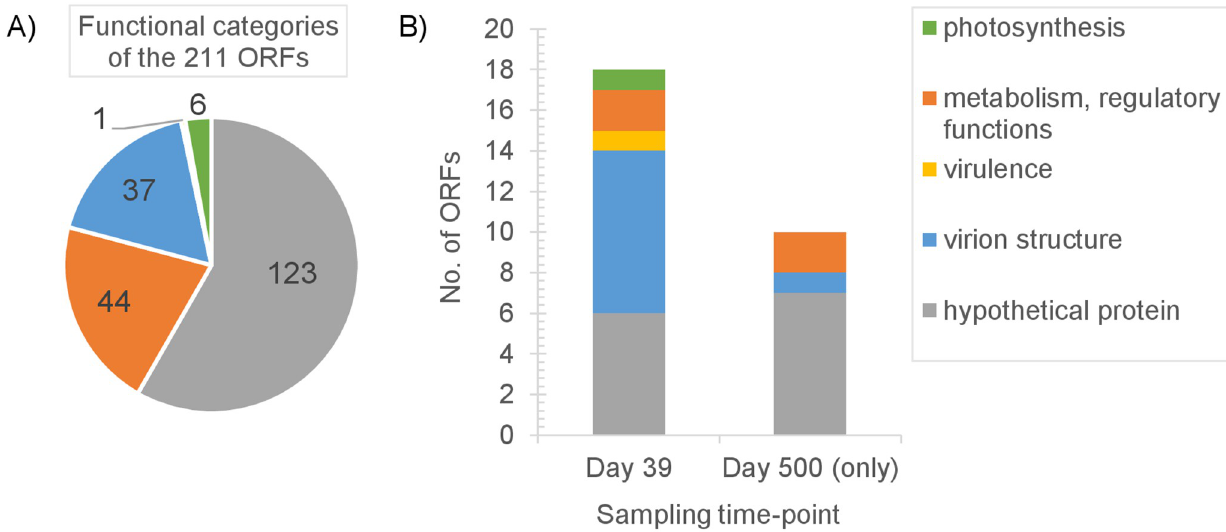
Fig 3. Cyanophage S-PM2d open reading frames (ORFs). The numbers and functional associations of S-PM2d ORFs A) in total; B) carrying non- synonymous mutations found on days 39 and 500 following infection of the host Synechococcus sp. WH7803.